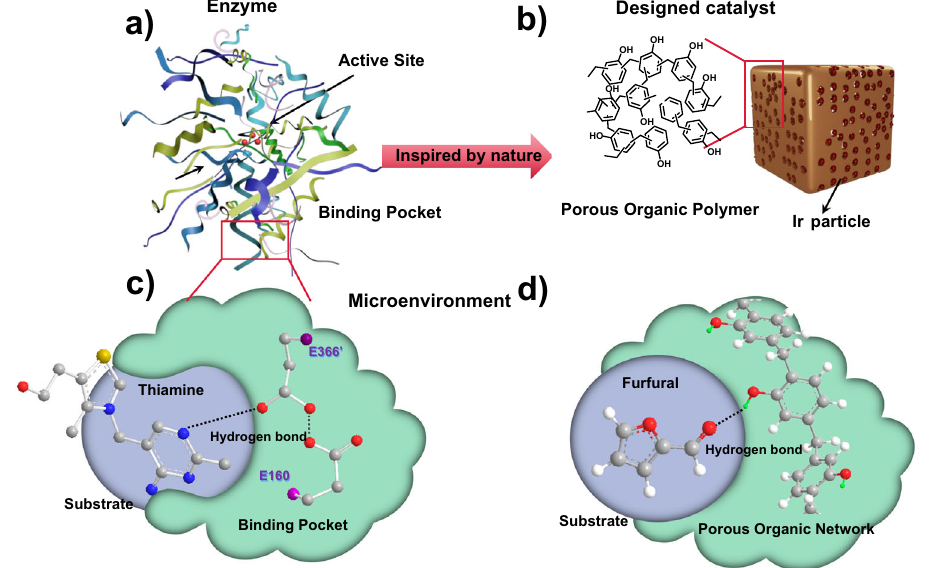
Fig. 1 | Enzymes inspired microenvironment-controlled catalyst. Schematic diagram of ( a ) enzyme structure and ( b ) designed catalyst porous catalyst. c Hydrogen bond interaction between the substrate thiamine and the human